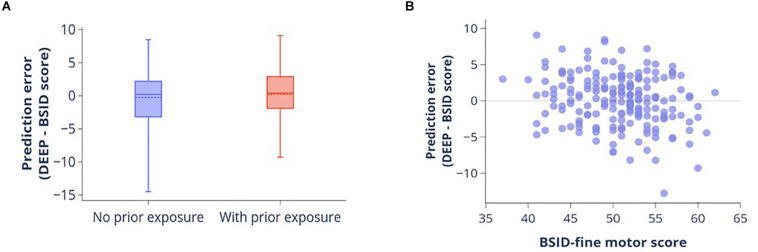
Impact of prior experience of playing digital games and fine motor skills on DEEP’s prediction accuracy. (A) Boxplot showing the distribution of prediction errors (DEEP-BSID-cognitive score) for children with and without prior exposure to playing games on a smart device. Mean (dotted line) and median (solid line) are shown. There is no significant difference in mean prediction error between the two groups. (B) Scatter plot of prediction error against fine motor score measured by the BSID-III fine motor domain subscale.